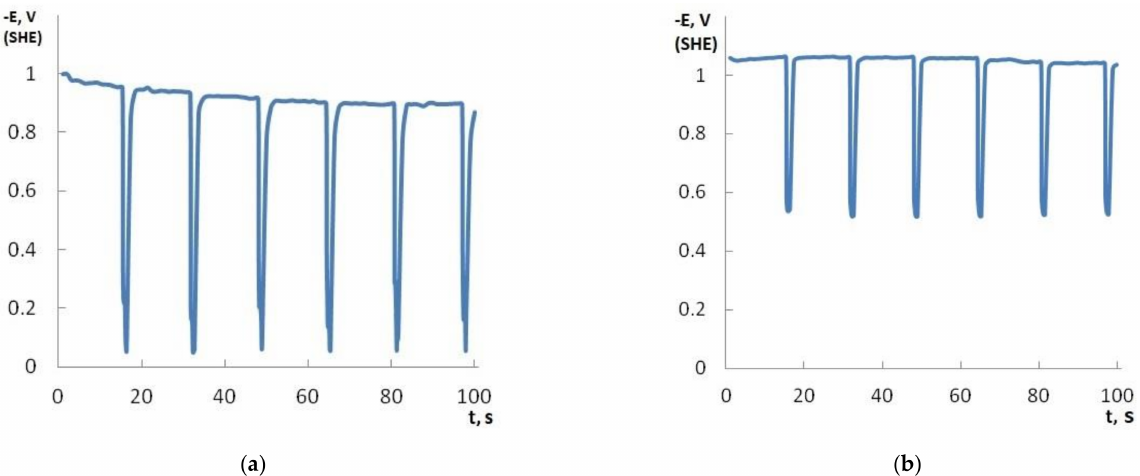
Figure 1. E, t-curves of electrodeposition of nickel ( a ) and nickel–GO CEC ( b ) at the time ratio of the cathodic and anodic periods t c /t a = 16:1 s.